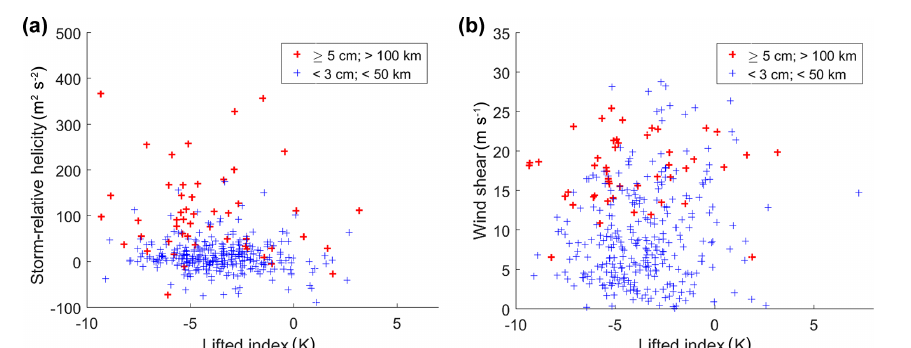
short non-frontal tracks form at a DLS value of 10.9 m s − 1